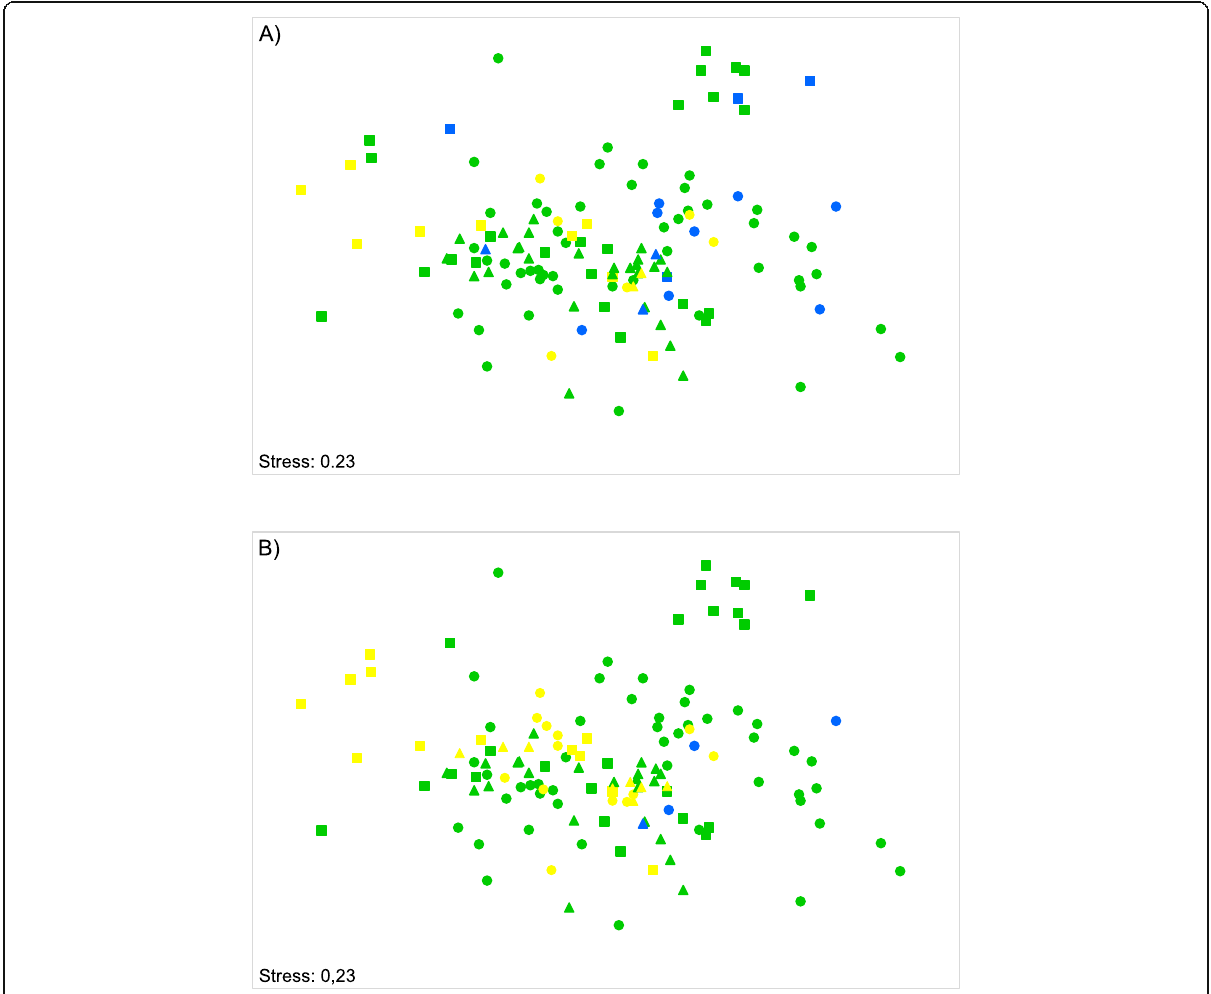
Fig. 8 Best ( a ) and poorest ( b ) ecological group assignment of species to obtain AMBI-1 and AMBI-2. AMBI values are superimposed in colors on each macrofauna replicate obtained in Caucahue Channel as represented by n MDS. The n MDS for abundance was obtained through the Bray- Curtis index and fourth root transformed data. For the environment factor (ENV), circles represent mussel farms (MYT), squares represent salmon farms (SAL) and triangles represent reference sites (REF). The color indicates the level of disturbance according to the AMBI: undisturbed (blue), slightly disturbed (green) and moderately disturbed